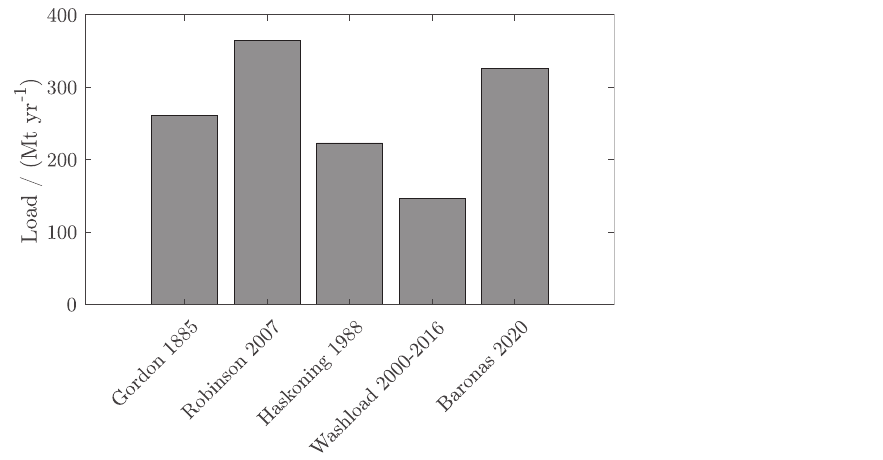
Fig 8. Comparison of washload with historic load